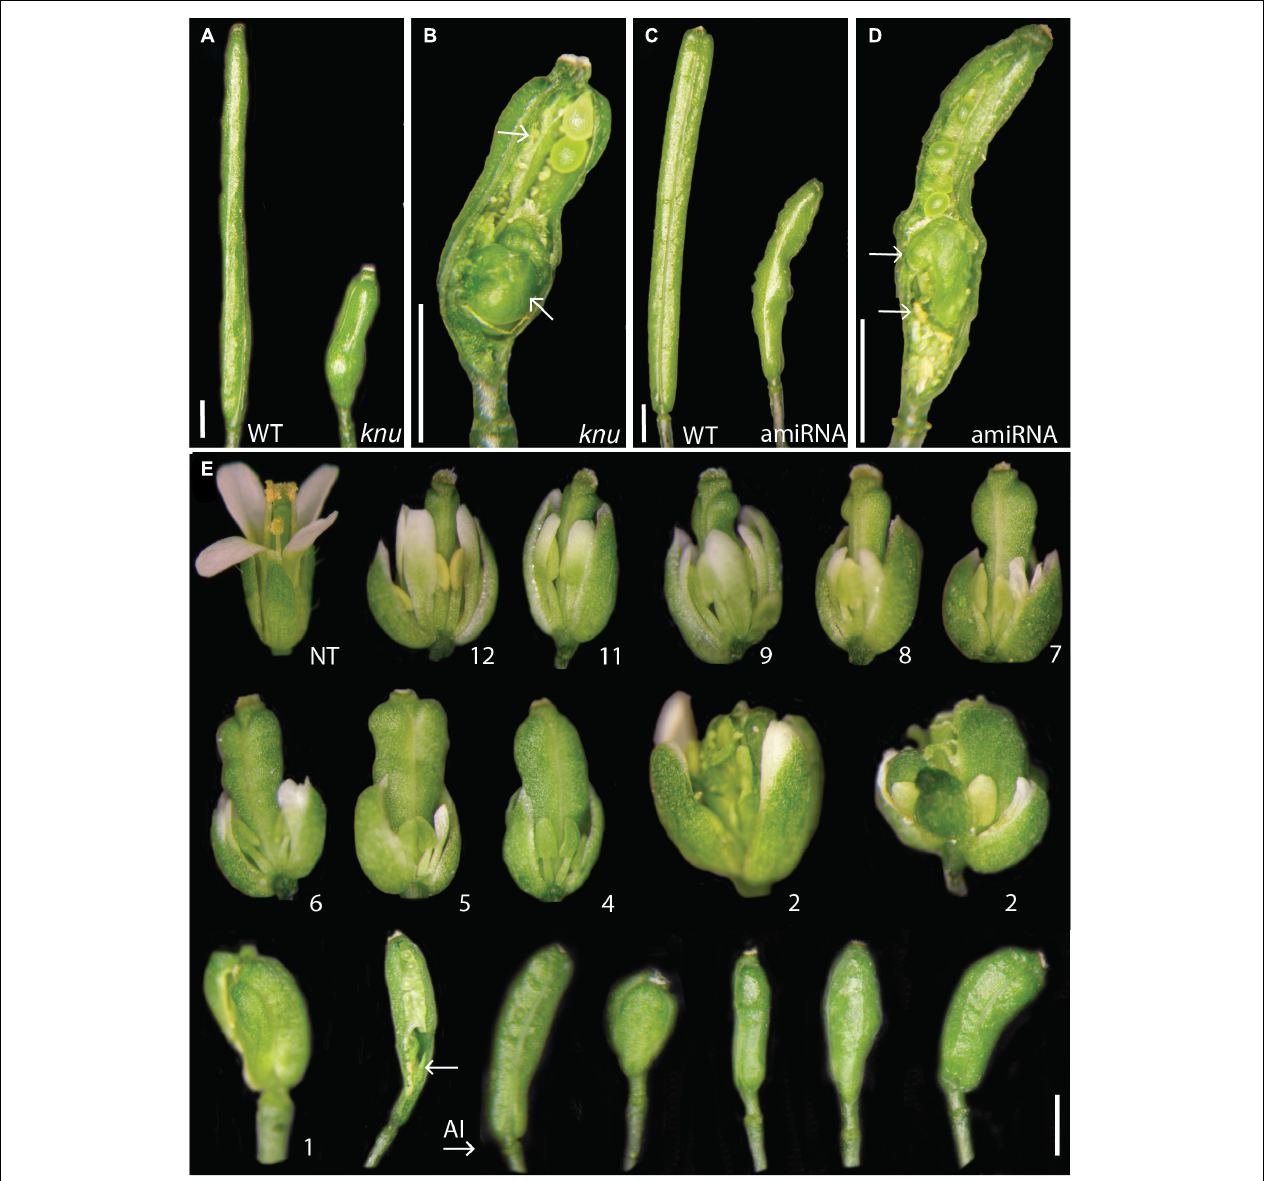
FIGURE 3 | AmiRNA-mediated perturbation of KNU activity. (A) Siliques of a wild-type (WT) and a knu -1 plant. (B) Silique of a knu- 1 plant with ectopic carpels and stamens (indicated by arrows). (C) Siliques of a wild-type plant and of a plant containing a p35S::KNU-amiRNA1 transgene. (D) Silique of a p35S::KNU-amiRNA1 plant with ectopic carpels and stamens (arrows). (E) Pulsed perturbation of KNU . Plants homozygous for a p35S::GR-LhG4/6xpOp::KNU-amiRNA1 transgene were treated three times (in 3-days intervals) with 10 µ M dexamethasone. The effects of KNU-amiRNA induction were monitored for 3 weeks following the start of dexamethasone treatments by analyzing the phenotypes of flowers that reached maturity. Numbers indicate the approximate stage a flower was at the time of the first dexamethasone treatment. “NT”: a flower of an untreated plant resembling the wild type. Flowers shown on the right of “AI” likely initiated after the first dexamethasone treatment. In the bottom row, second flower from the left, an arrow marks ectopic organs in a knu -like silique (a valve has been partially removed to reveal internal structures). Size bars: 2